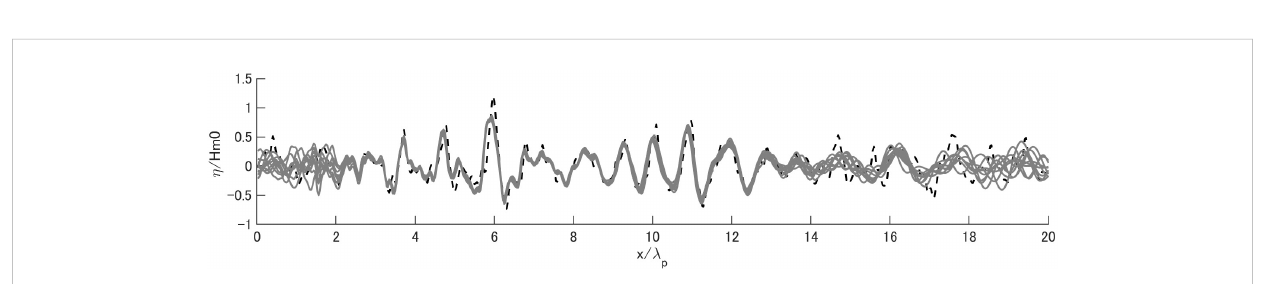
FIGURE 9 Analytical values for the initial value ( t = -5 T p ) obtained after 100 iterations with SWEAD-S (e). The truth is shown as a black dashed line, and the analytical value is shown as a gray dashed line for each realization. The wave group leading to the freak wave existed around x/ l p = 11 (Figure 4).